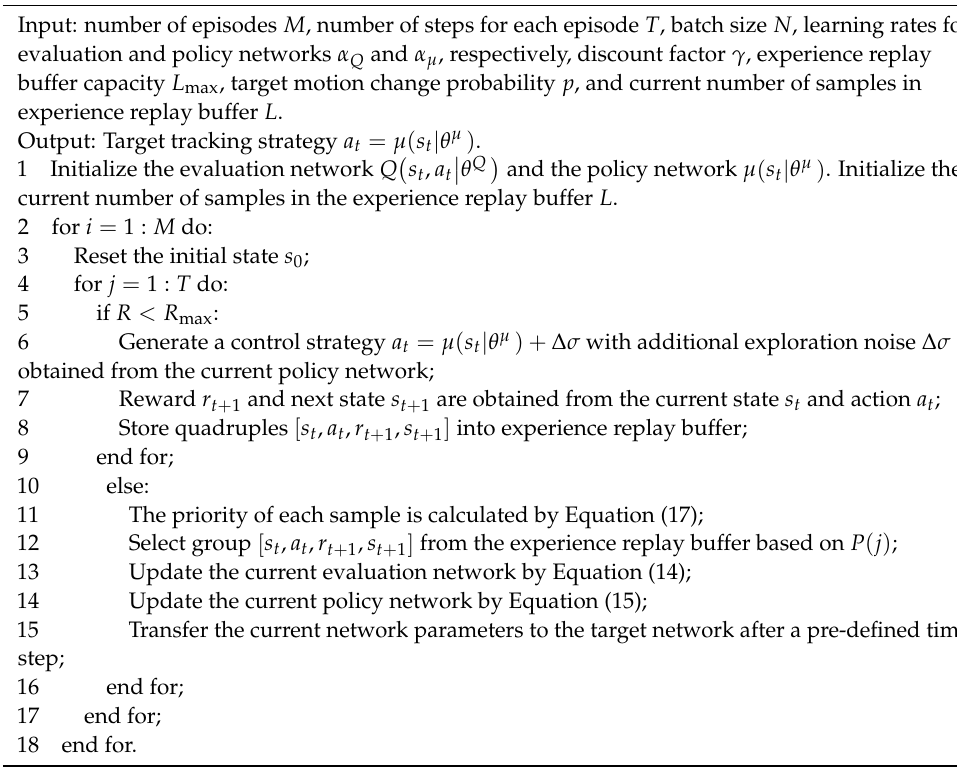
Algorithm 1. AERDPG for the target tracking of the